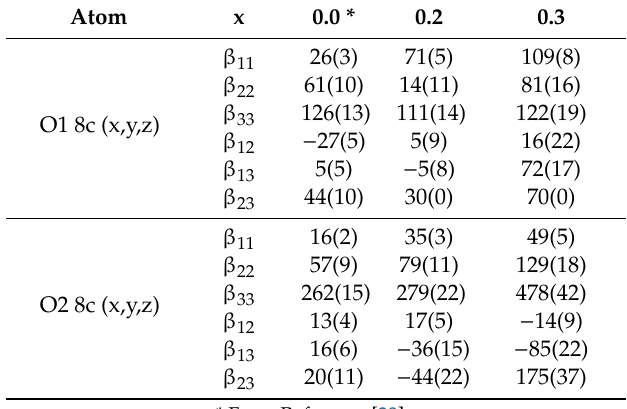
Table 3. Anisotropic displacement factors for O1 and O2 in La 1.2 Sr 0.6 Ba 0.2 InO 4 + δ from NPD data.